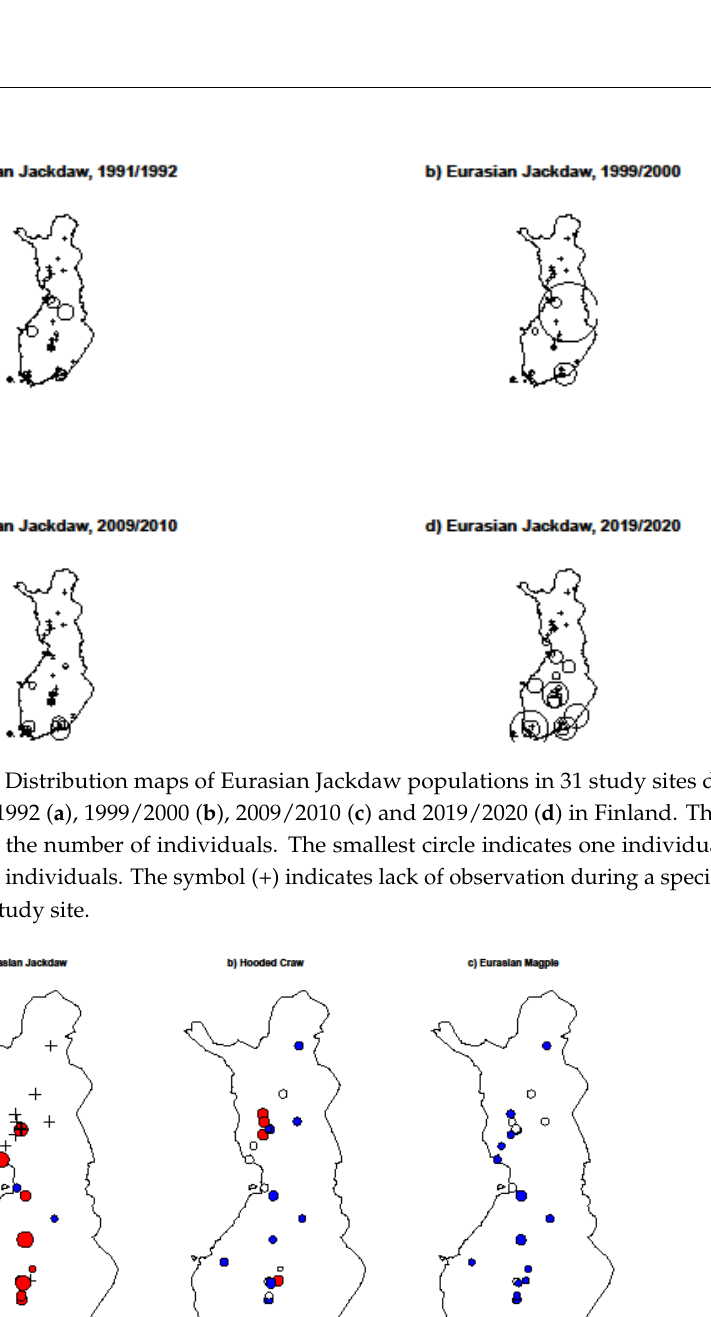
Figure 2. Population growth rates ( λ ) of the Eurasian Jackdaw (Figure 2 a ), Hooded Crow (Figure 2 b ) and Eurasian Magpie (Figure 2 c ) populations in 31 study sites during 1991/1992–2019/2020 in Finland. The size of the dot indicates the population growth rate (the larger the dot, the greater the change) and the color of the dot indicates direction of the growth (red positive; blue negative; and open dot zero growth rates). The symbol (+) indicates a lack of observation during the four winters.